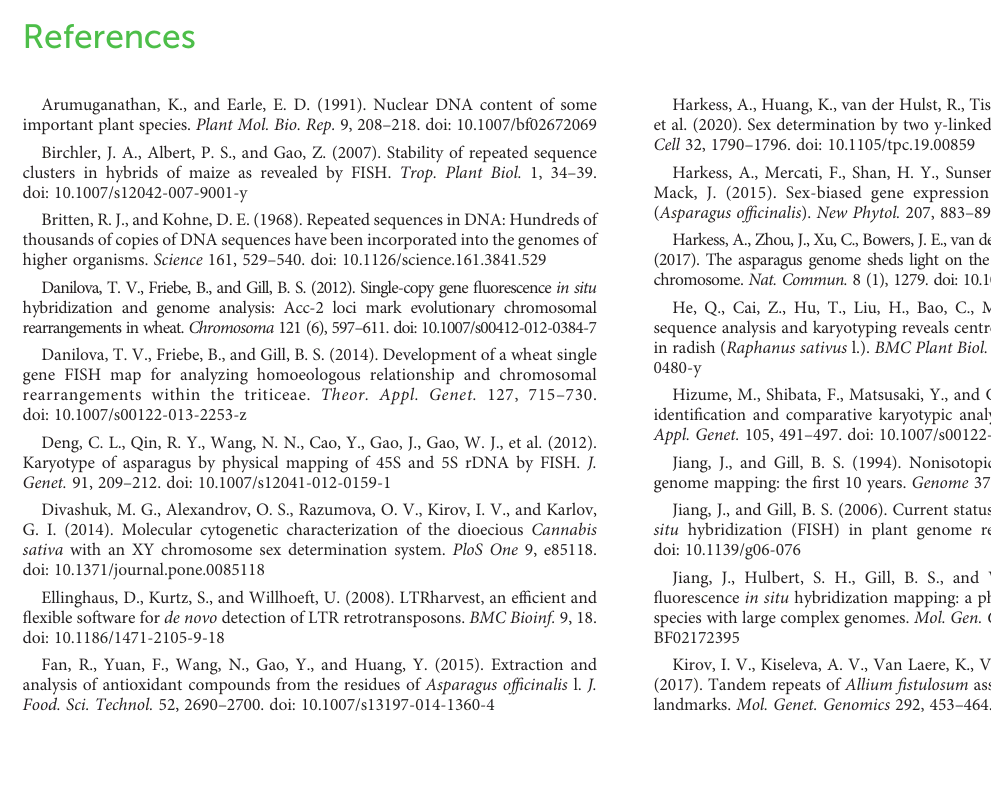
SUPPLEMENTARY FIGURE 1 Effect of blocking DNA on hybridization results using the Ao8-8 probe. (A – D) Hybridization results with different ratios of blocking DNA to the Ao8-8 probe. The red signal on the chromosome long arm is the Ao8-8 hybridization signal, and the green signal is the 45S rDNA hybridization signal. Scale bar = 10 m